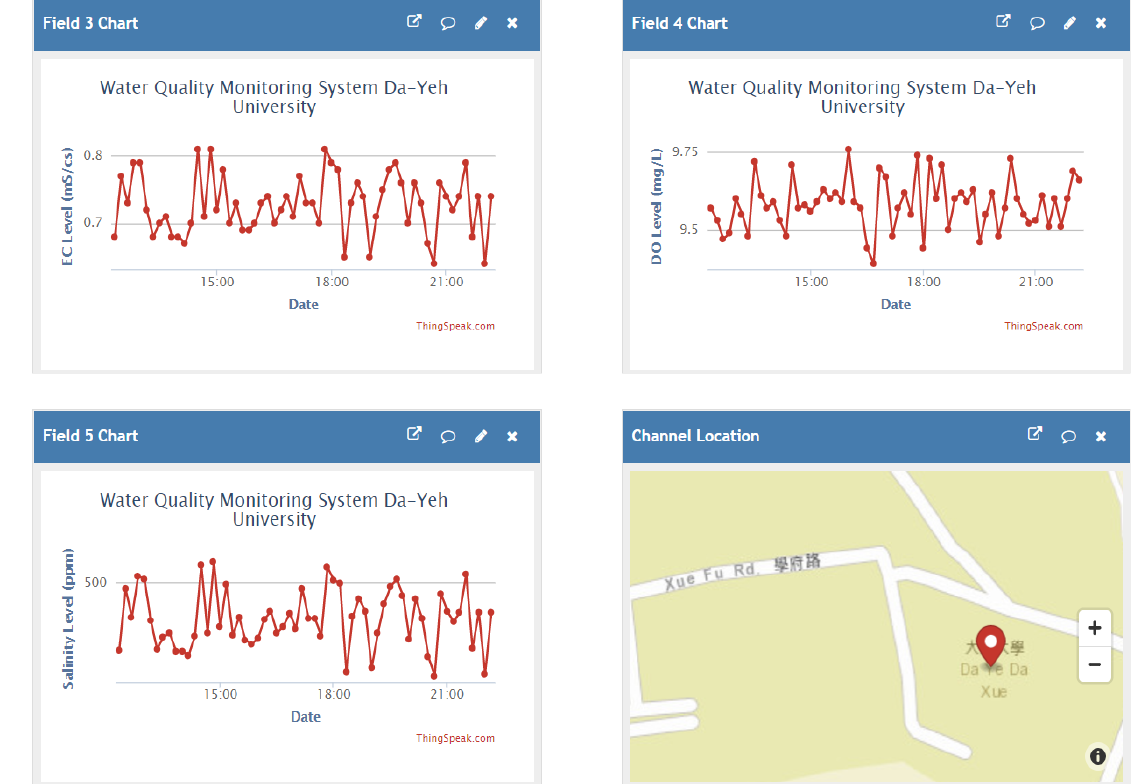
Figure 4. Snapshot of ThingSpeak IoT for water quality monitoring system.